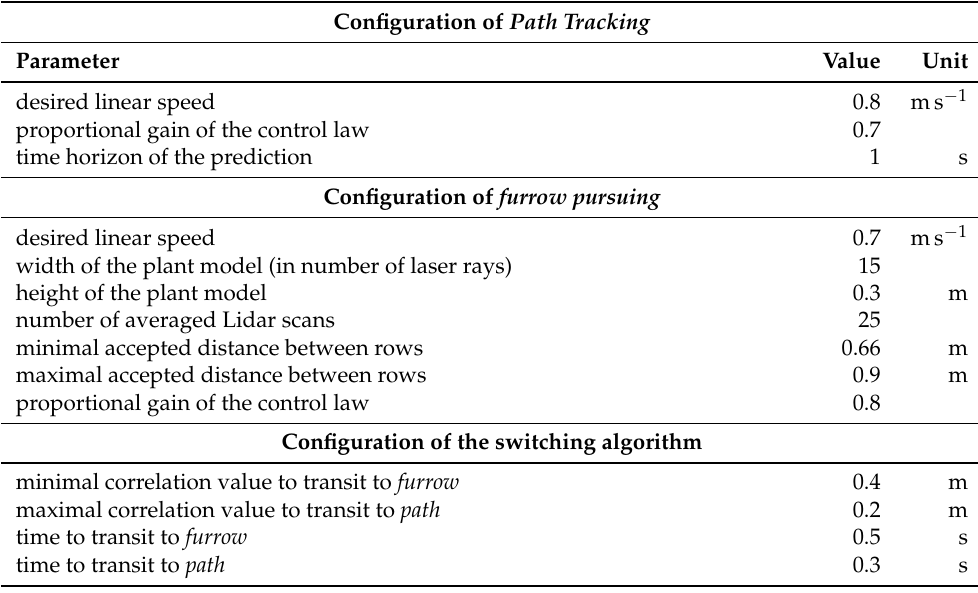
Figure 9. Presentation of experiment 2. ( a ) Scenario; ( b ) picture of the robot in one of the bean plots. Table 2. Configuration of the experimentation with furrow pursuing